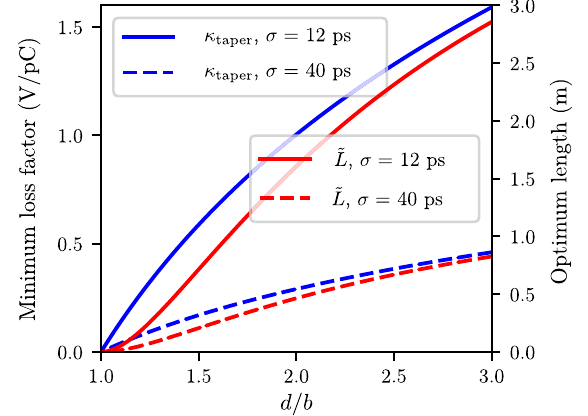
FIG. 15. The minimum loss factor of a taper-out and the optimum taper length as a function of ratio d=b obtained from Eqs. (12), (14) for parameters of noncolliding (solid lines) and colliding (dashed lines) beams in the Z machine.